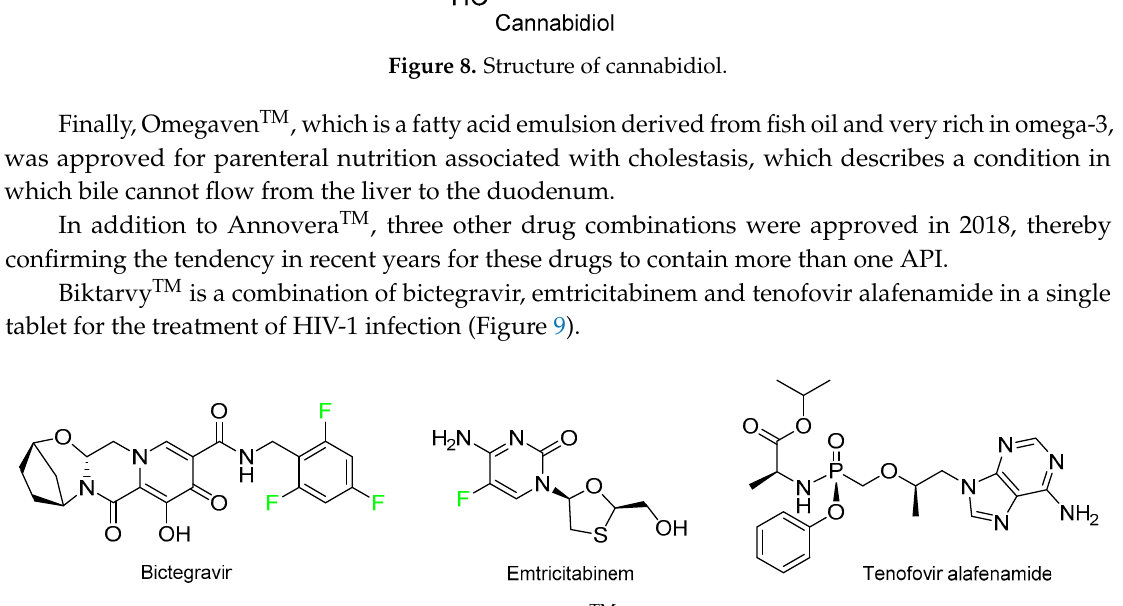
Figure 10. Structure of Akynzeo ™ , a drug combination. Symdeko ™ , which has been approved for the treatment of cystic fibrosis, is a combination of tezacaftor and ivacaftor (Figure 11). The structure of the former also contains several F. Figure 11. Structure of Symdeko ™ , a drug combination. In addition to eravacycline, bictegravir and emtricitabine –part of Biktarvy ™ –, fosnetupitant – part of Akynzeo ™ –, and tezacaftor–part of Symdeko ™ –, another 14 drugs contain F. This implies that almost one third (18 over 59) of all drugs approved by the FDA during 2018 contain F. Taking into account the NCE alone, this proportion increases to slightly more than 40% (18 vs . 42). In addition to fosnetupitant, five more drugs with trifluoromethyl groups were approved in 2018. Apalutamide (Erleada ™ ), which contains a trifluoromethyl pyridine and an additional fluorophenyl moiety, is indicated for the treatment of non-metastatic castration-resistant prostate cancer. Apalutamide could be considered the “n” generation of flutamide (Eulexin ™ ), which also contains the trifluoromethyl group and is indicated for the treatment of prostate cancer (Figure 12).